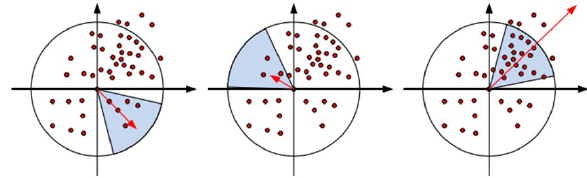
Figure 1. Finding the Main Direction Pattern of Feature